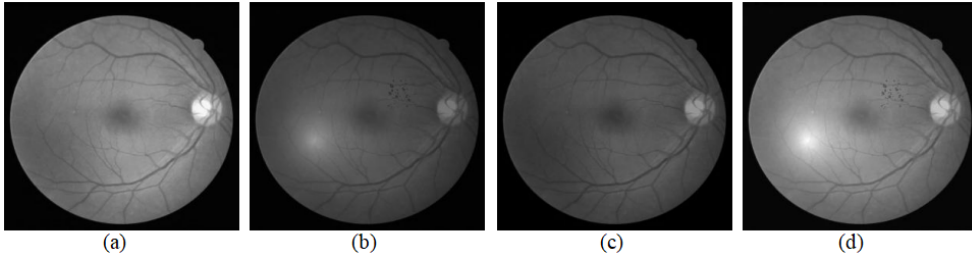
Figure 1. Intensity normalization of the image pair. The original image taken as the reference image is from DRIVE. A small noise patch is attached on the reference image and the intensity is adjusted which is taken as the current image. ( a , b ) are the grayscale images of the reference image and current image, and ( c , d ) are results of intensity normalization for ( a , b